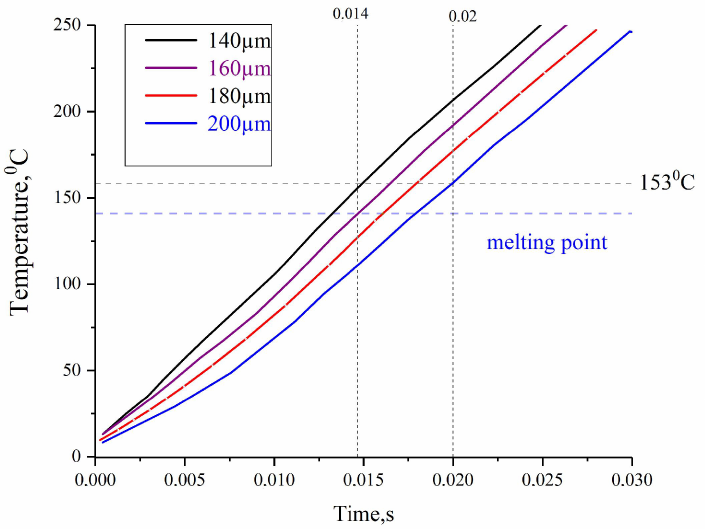
Figure 13. Dependence of the temperature of the core of the UHMWPE particle during the time of exposure to the heat flux. Experiment